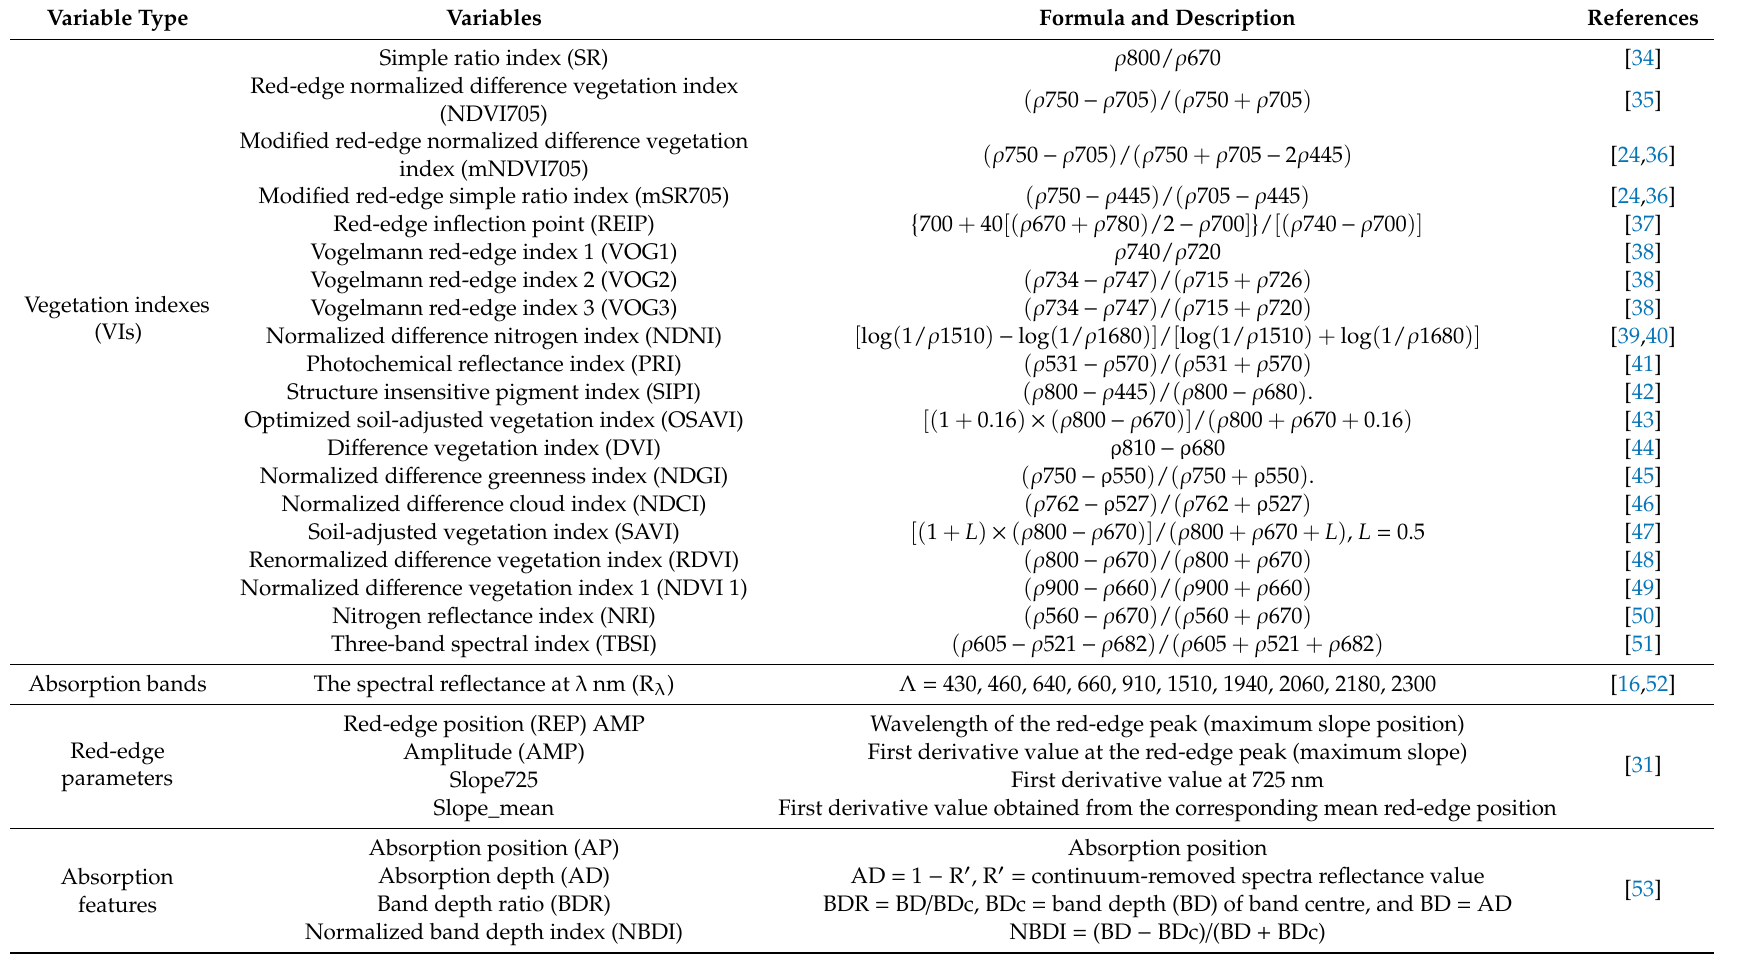
Table 1. Spectral variables used for estimating forage